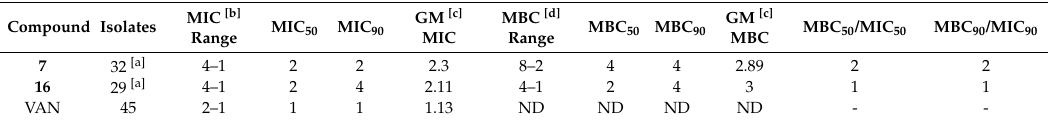
Table 2. Summary of antibacterial activity of compounds 7 , 16 and vancomycin against MDR S. aureus . MIC and MBC ( µ